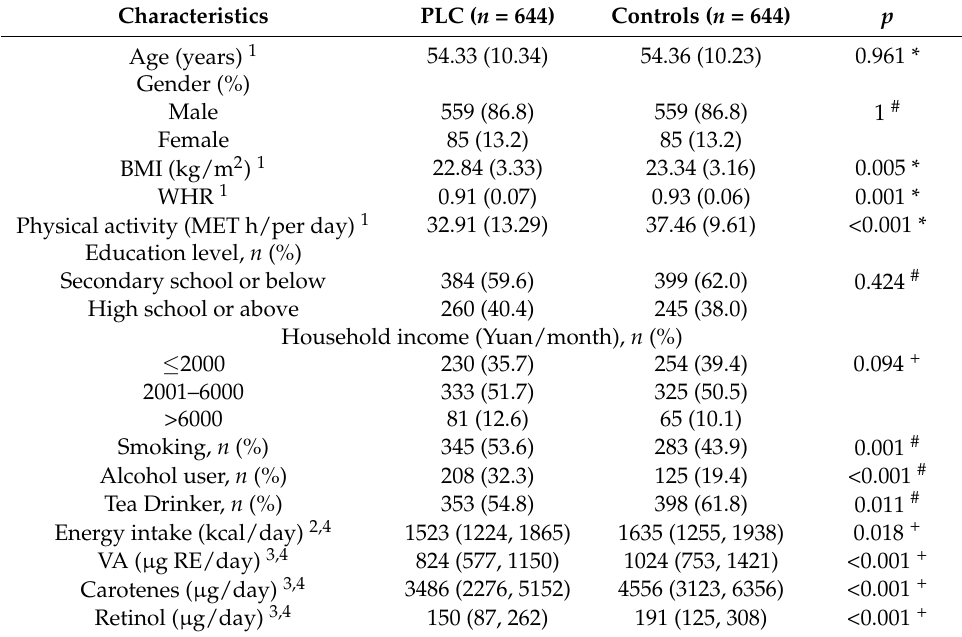
Table 1. Comparison of general characteristics between primary liver cancer cases and